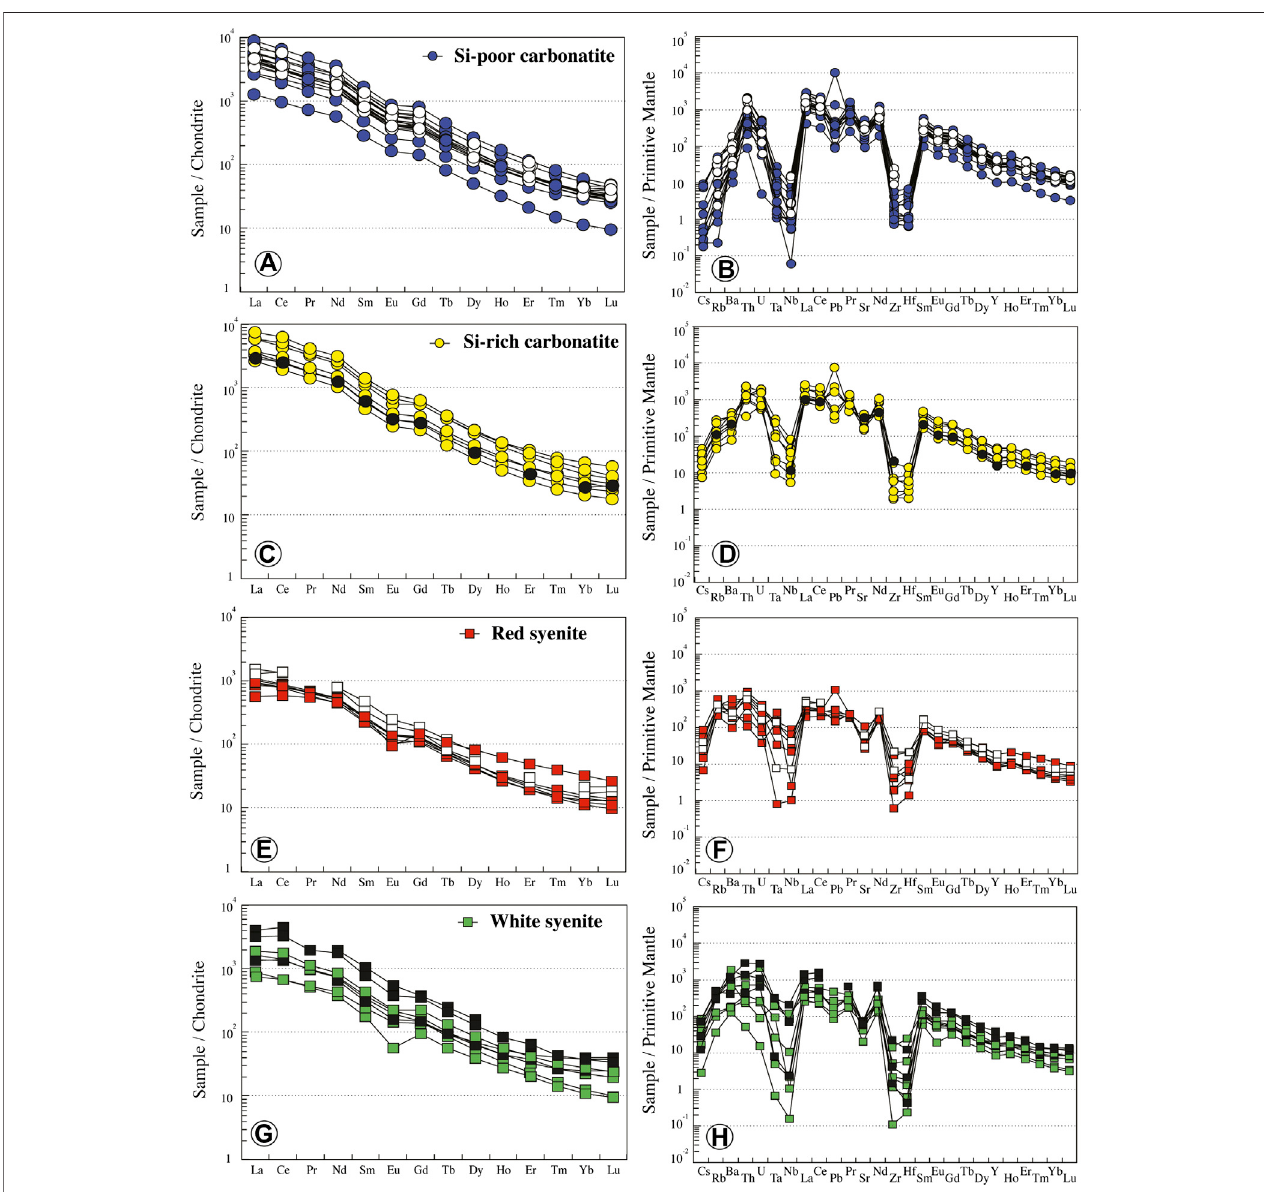
FIGURE 6 | Normalized REE and trace element contents of Ihouhaouene carbonatites and associated syenites. Primitive mantle values and chondrite values are obtained from Sun and McDonough (1989). Symbols as in Figure 4 .